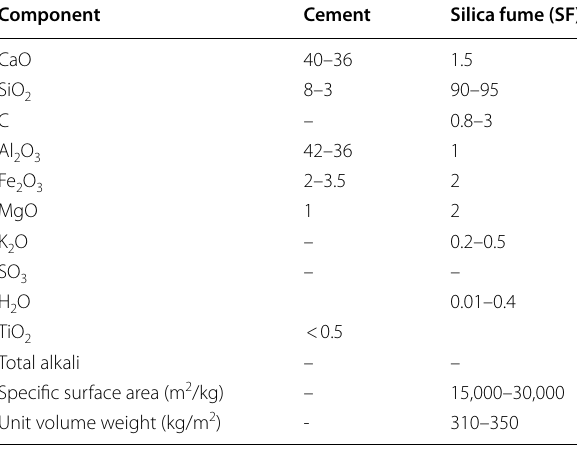
Table 1 Physical and chemical specifications of the cement and silica